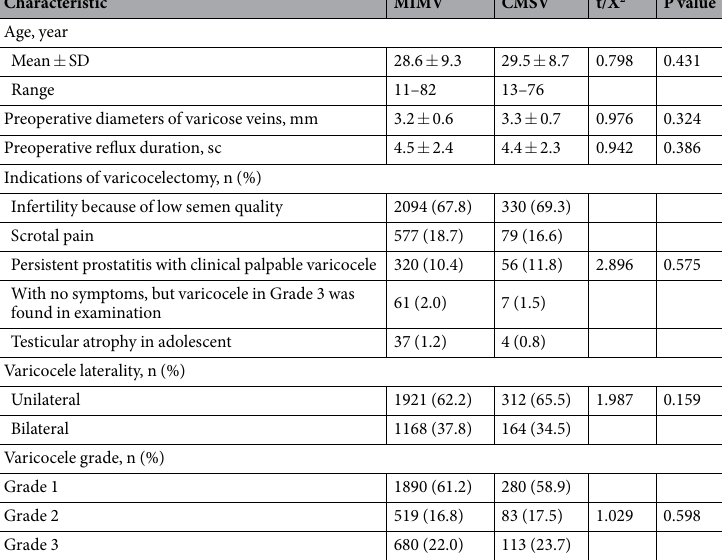
Table 1. Characteristics of all the patients in two